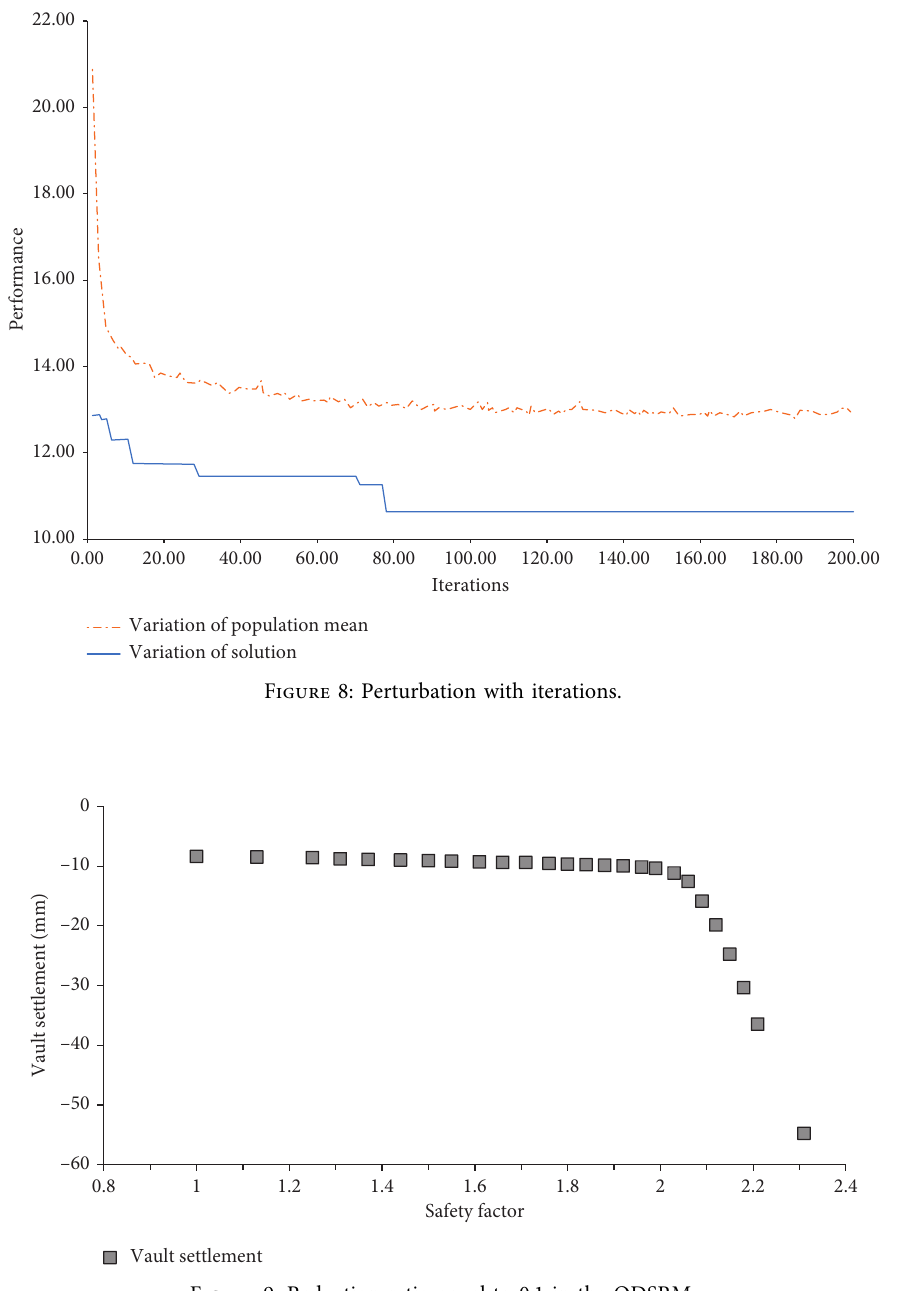
Figure 9: Reduction ratio equal to 0.1 in the